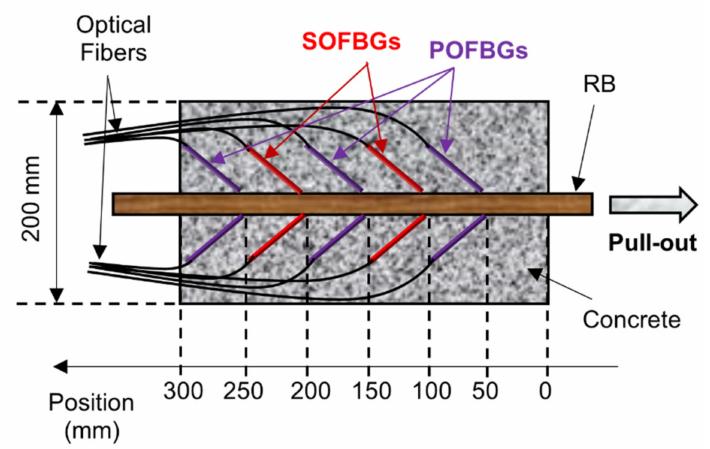
Figure 3. Location of the FBG based sensors inside the RC sample.